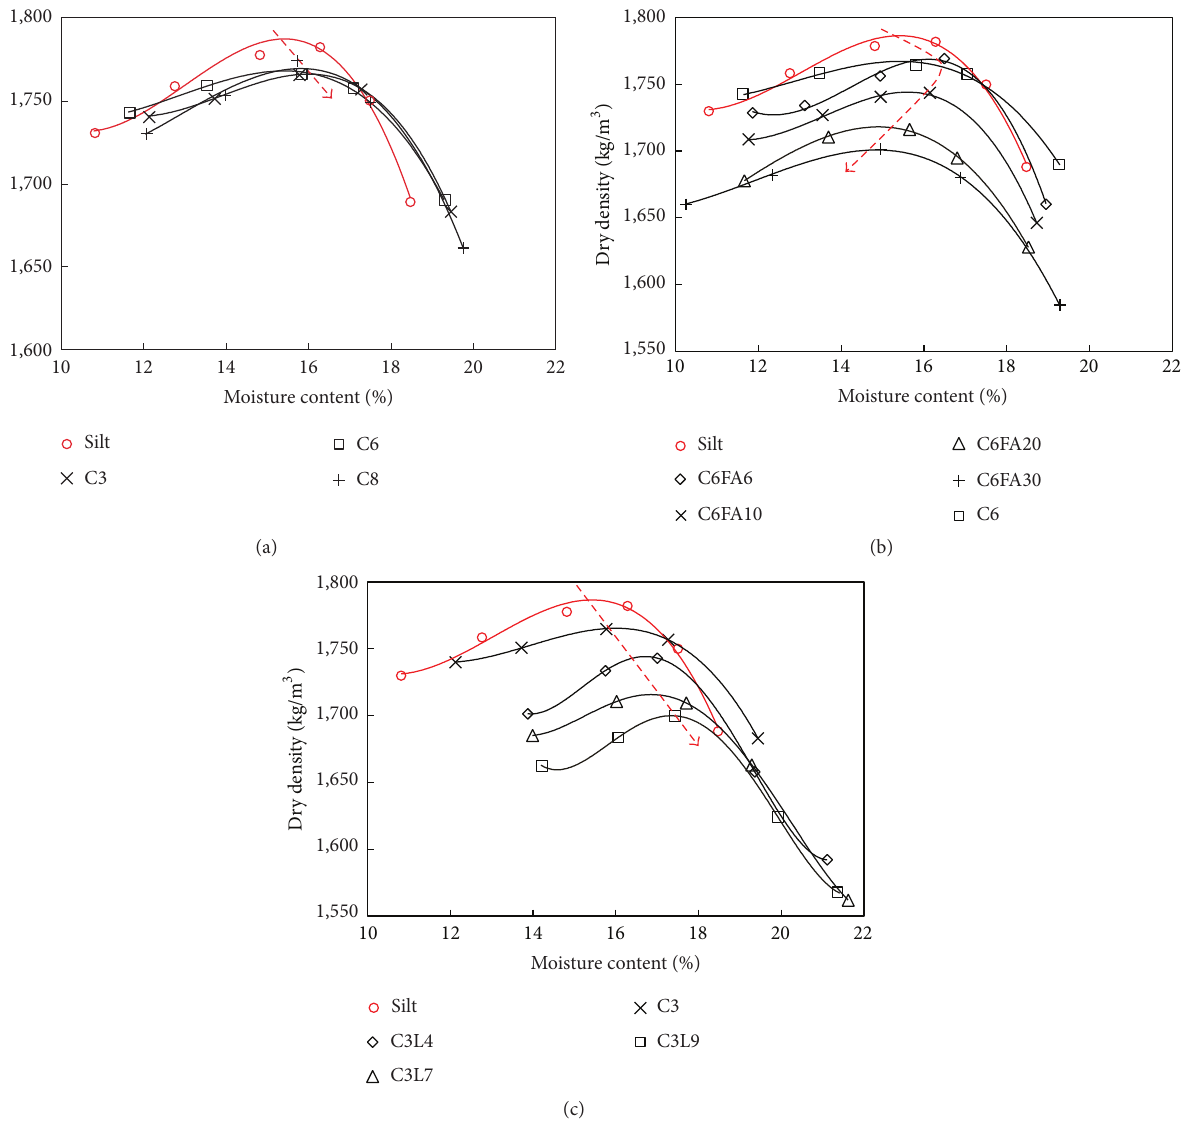
Figure 3: Proctor compaction test results: (a) cement-treated silt, (b) cement-fly ash-treated silt, and (c) cement-lime-treated silt.